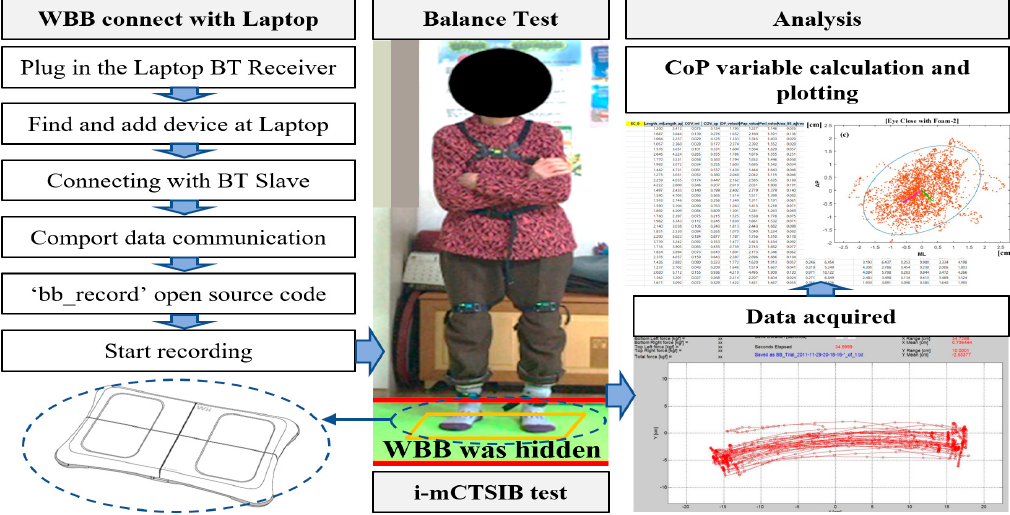
Figure 2. WBB connection and data acquisition algorithm.